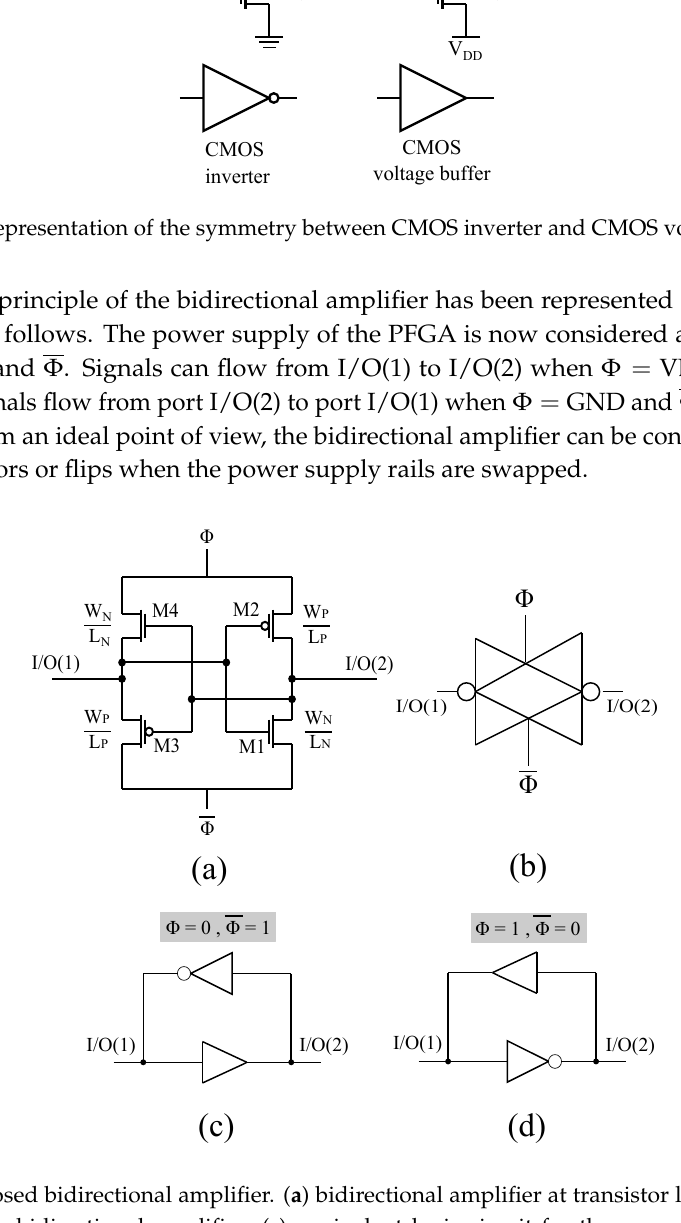
Figure 6. Proposed bidirectional amplifier. ( a ) bidirectional amplifier at transistor level; ( b ) symbol adopted for the bidirectional amplifier; ( c ) equivalent logic circuit for the case: Φ = 0, Φ = 1; ( d ) equivalent logic circuit for the case: Φ = 1, Φ =